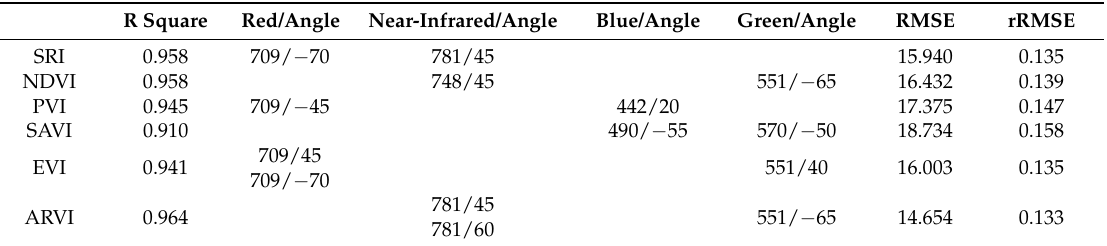
Table 7. Optimal bands and angles using LUT.